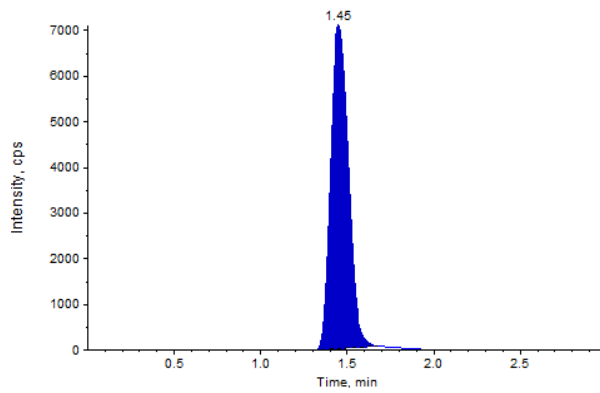
Figure 2. LC ‐ MS/MS chromatogram of diosmetin from plasma sample of a treated volunteer. Figure 2. LC-MS/MS chromatogram of diosmetin from plasma sample of a treated volunteer.